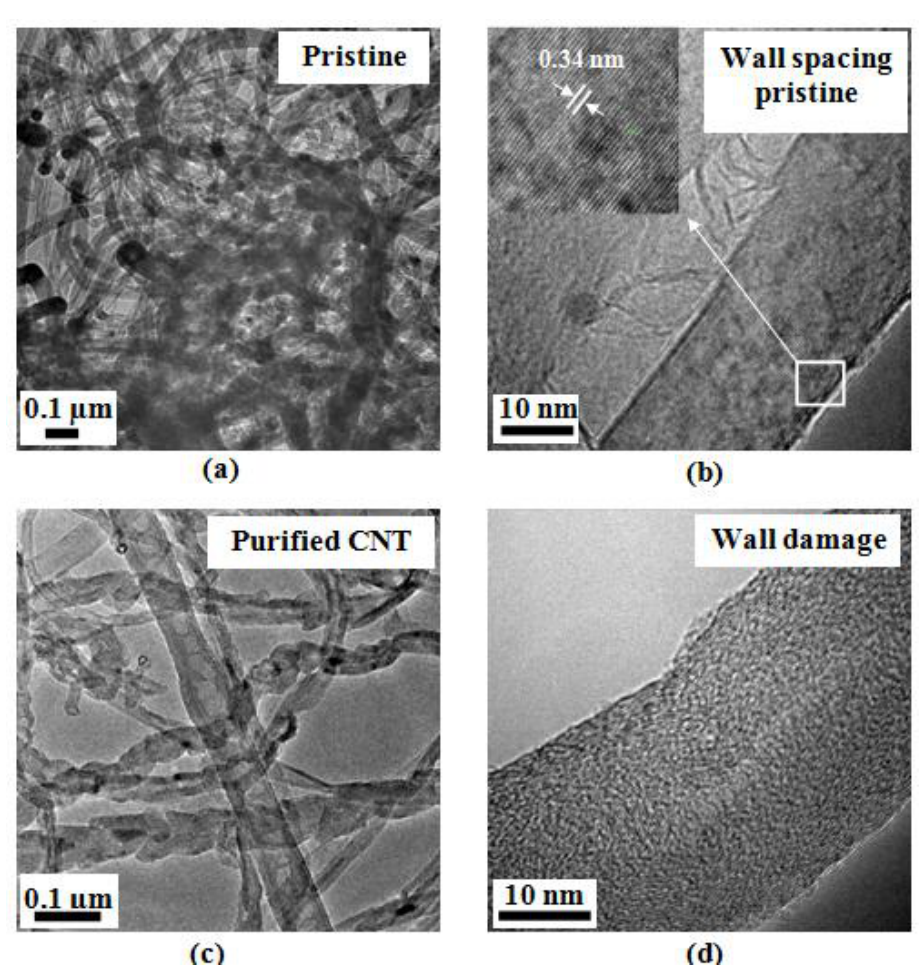
Figure 2. TEM images of MWCNT at different magnifications; ( a ) as-prepared nanotubes (pristine); ( b ) HRTEM of the graphitic layer of the CNT walls; ( c ) acid treated CNTs and ( d ) damage produced by purification at the walls of